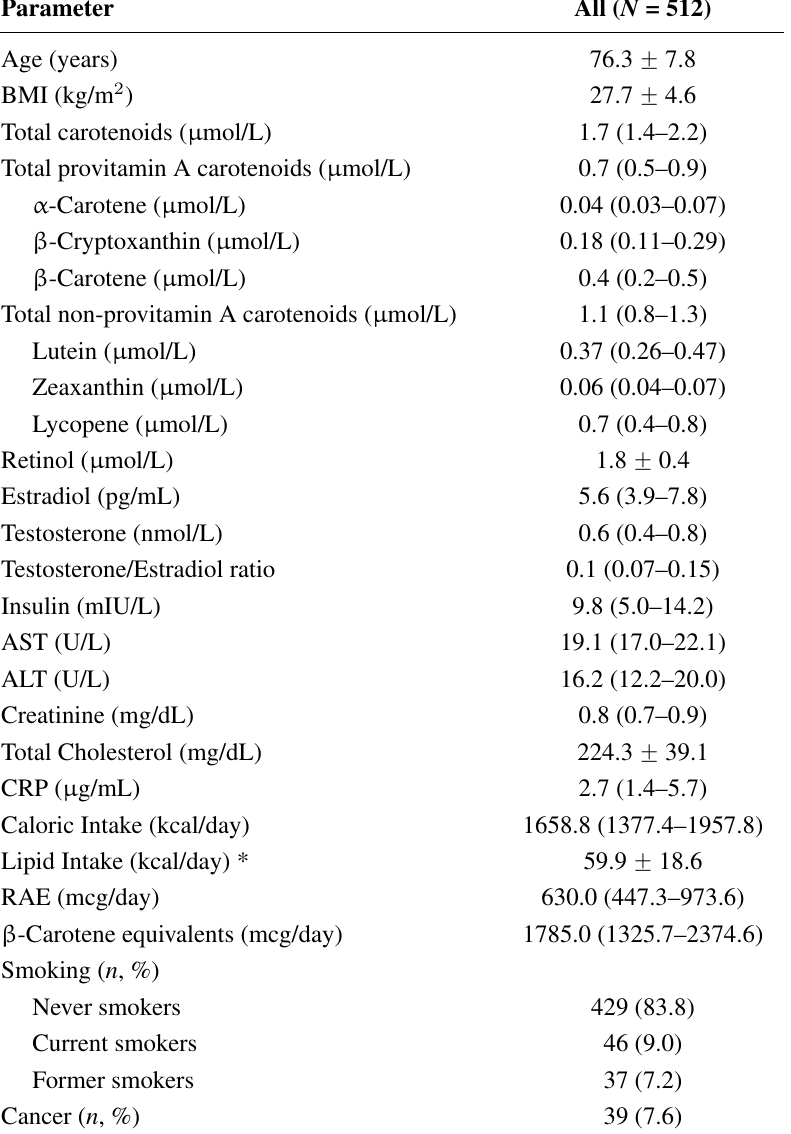
Table 1. Characteristics of the study population.